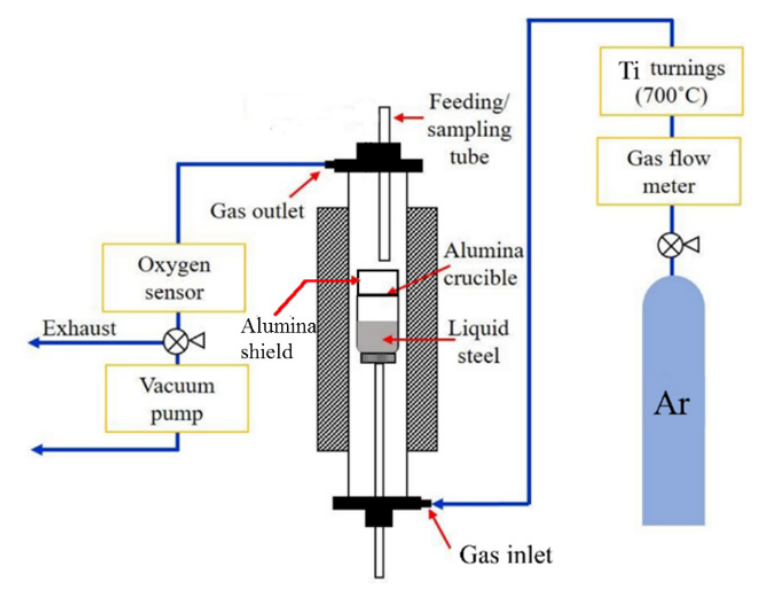
Figure 1. Schematic diagram of the experimental setup.